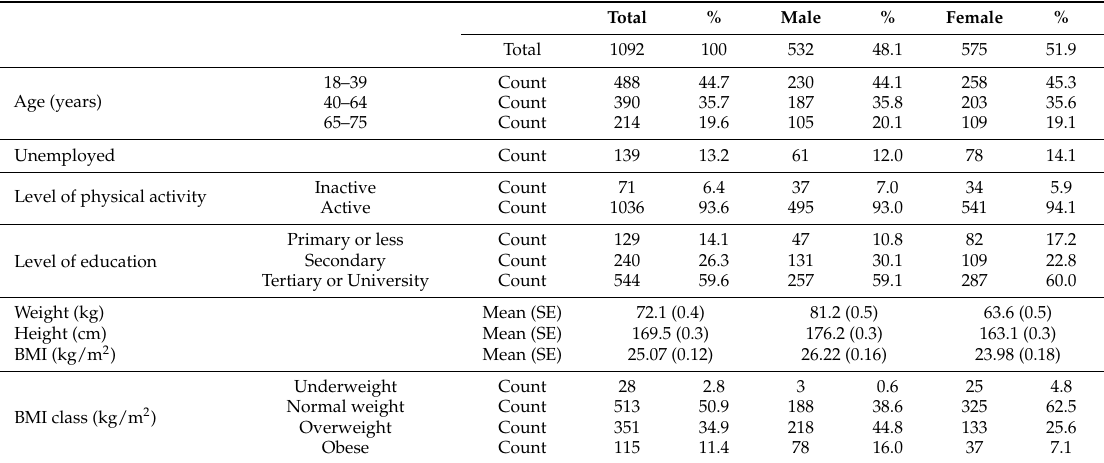
Table 1. Descriptive characteristics of subjects that completed the WBQ ( n =